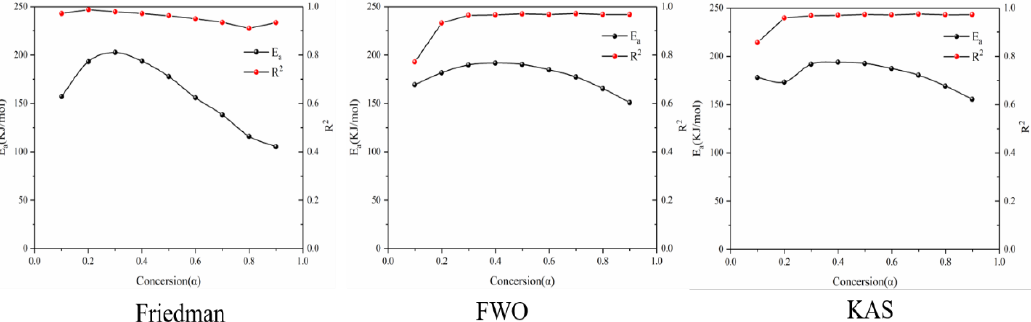
Figure 8. Conversion curve of the second stage of battery material pyrolysis.